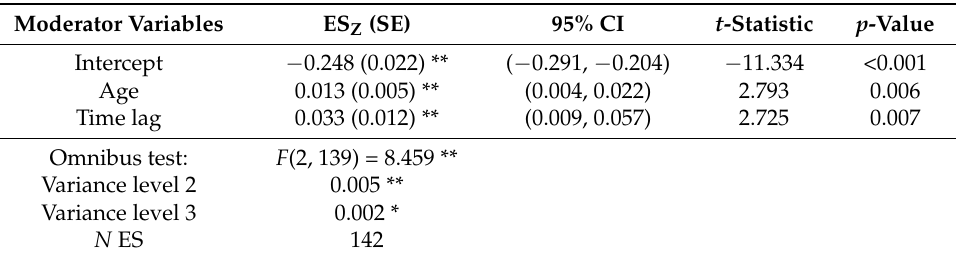
Table 4. Results for the multiple moderator